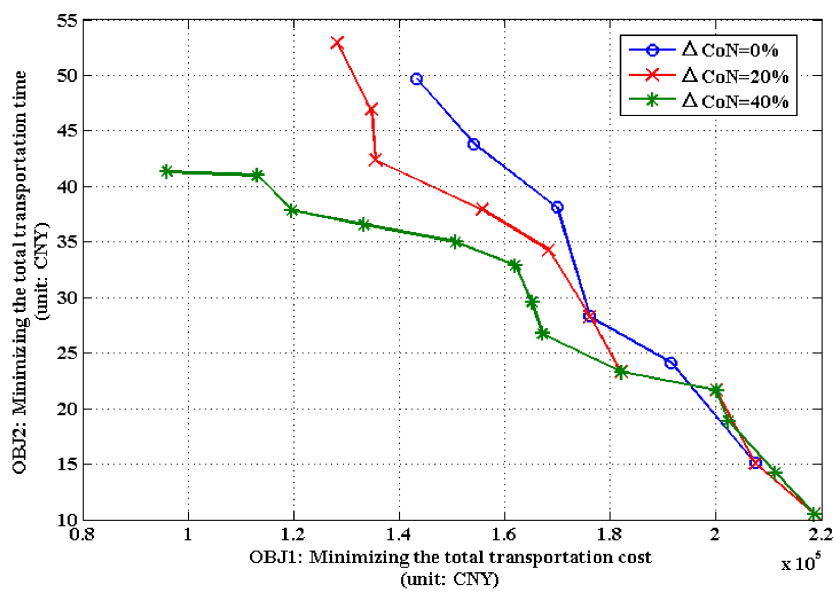
Figure 8. Sensitivity analysis of the capacity of the multi-modal transportation network on the Pareto